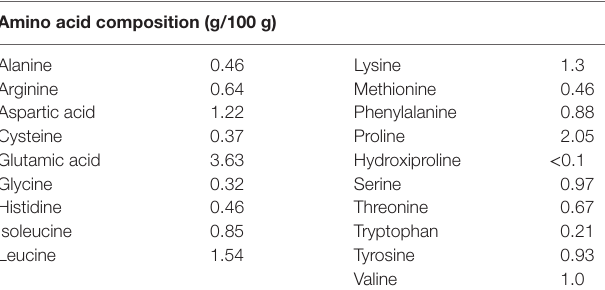
Table 2 | Amino acid composition of AA diet (modified AIN 93G).